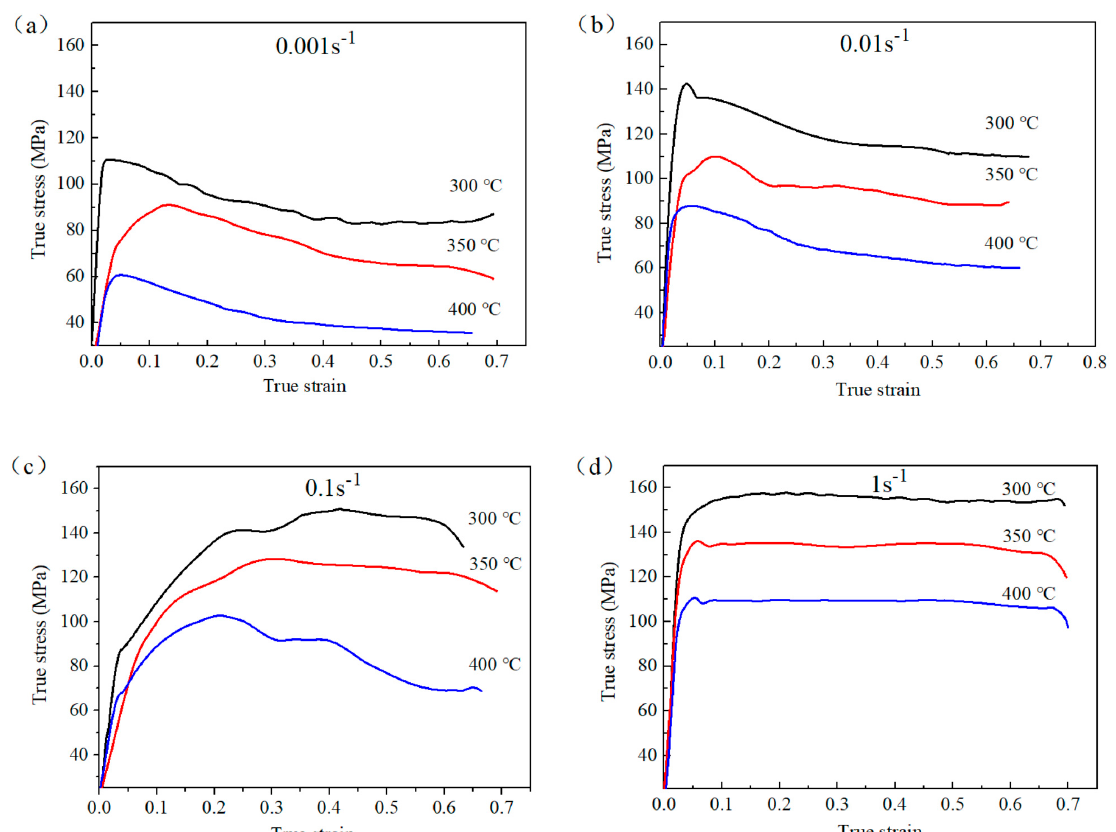
Figure 2. True-stress–true-strain curves at several strain rates and temperatures ( a ) 0.001 s − 1 , 300–400 °C; ( b ) 0.01 s − 1 , 300–400 °C; ( c ) 0.1 s − 1 , 300–400 °C; and ( d ) 1 s − 1 , 300–400 °C.